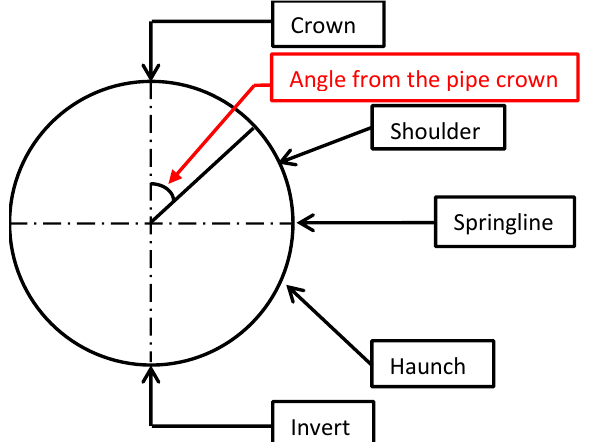
Figure 1. Terminology of the pipe sections.